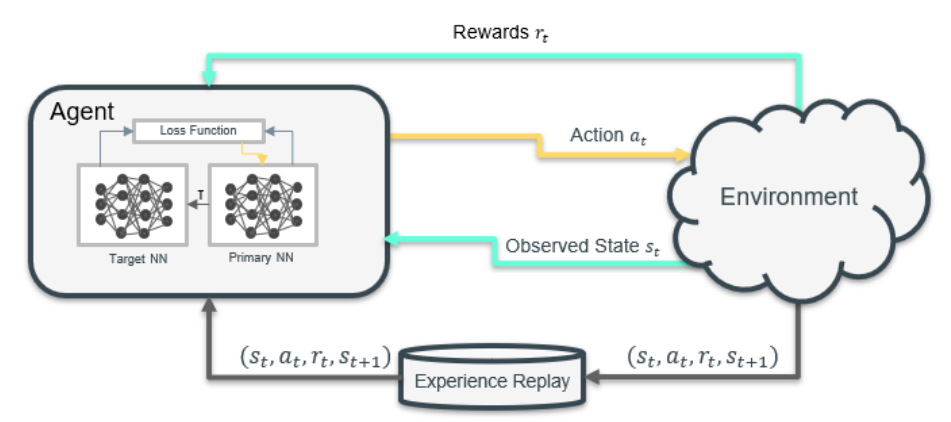
Figure 9. DQL with Experience